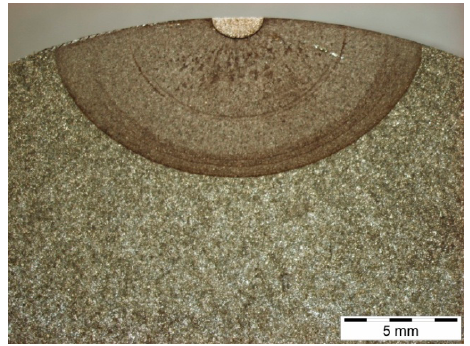
Figure 6. Representation of fracture surface for specimen utilized within Overload test #1.